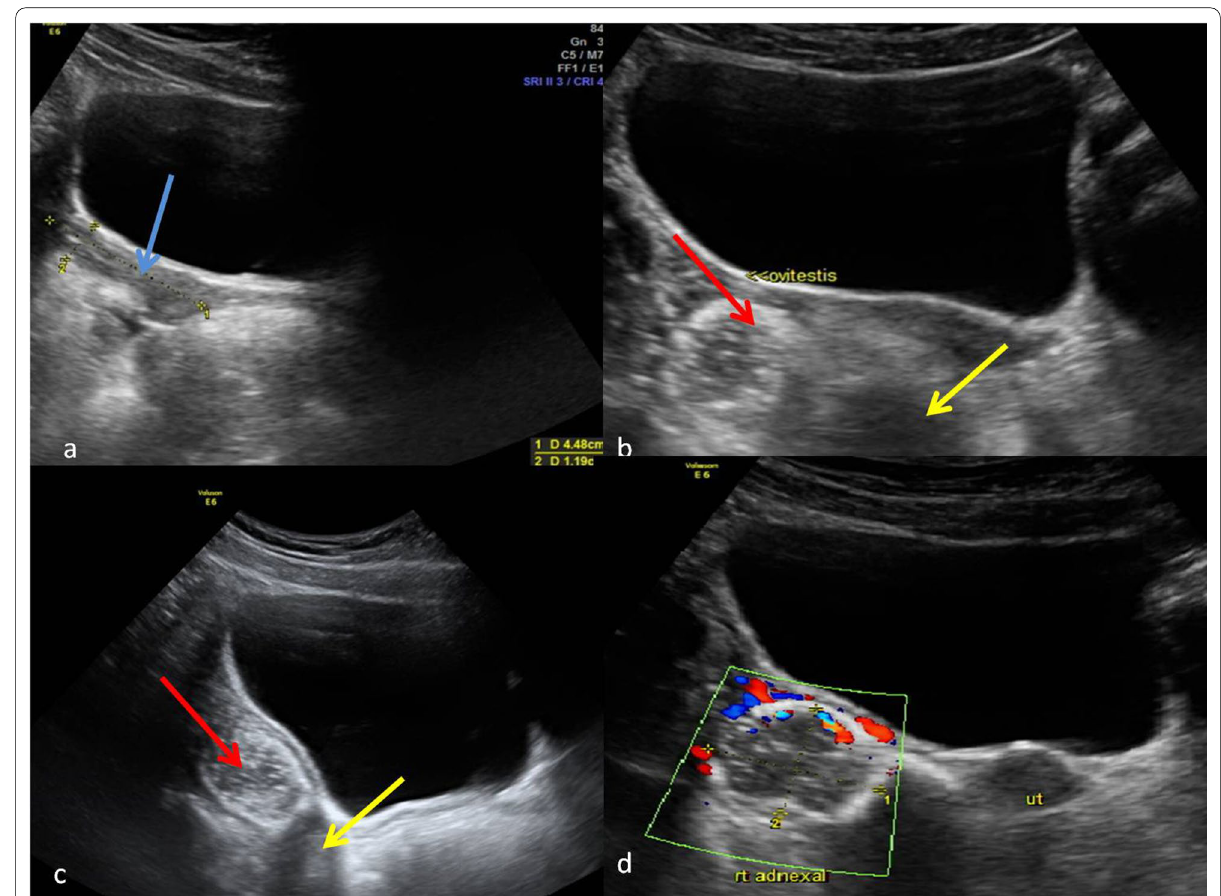
Fig. 1 Pelvic ultrasound revealed an infantile uterus (blue arrow) ( a ) with a right adnexal solid lesion showing apparently two parts; the superior one (red arrow) elicited mixed echogenicity mainly isoechoic and the inferior one (yellow arrow) was hypoechoic with posterior shadowing ( b , c ). It displayed increased vascularity on color Doppler ( d